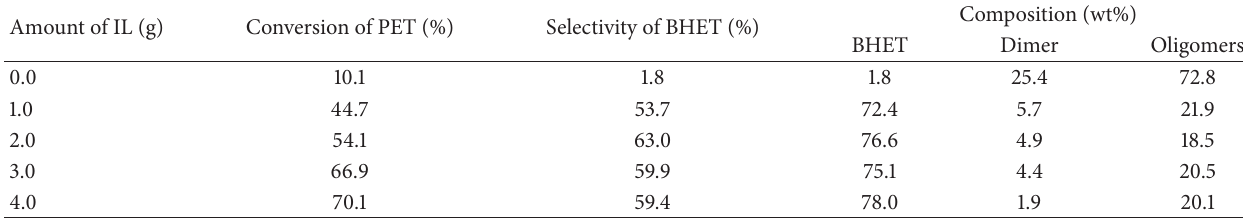
Table 2: The amount of catalyst, influence on the glycolysis process